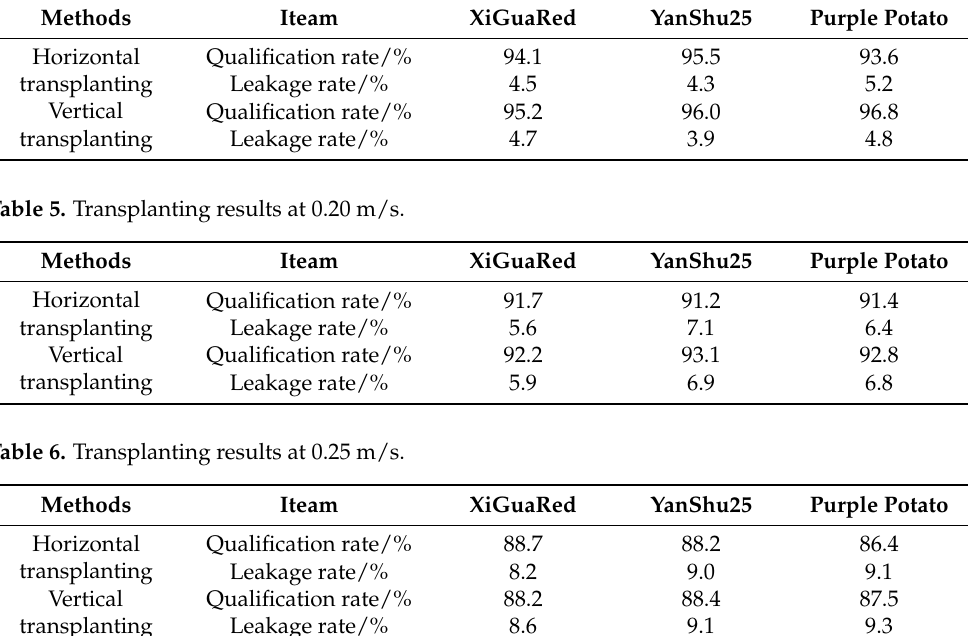
Table 6. Transplanting results at 0.25 m/s.